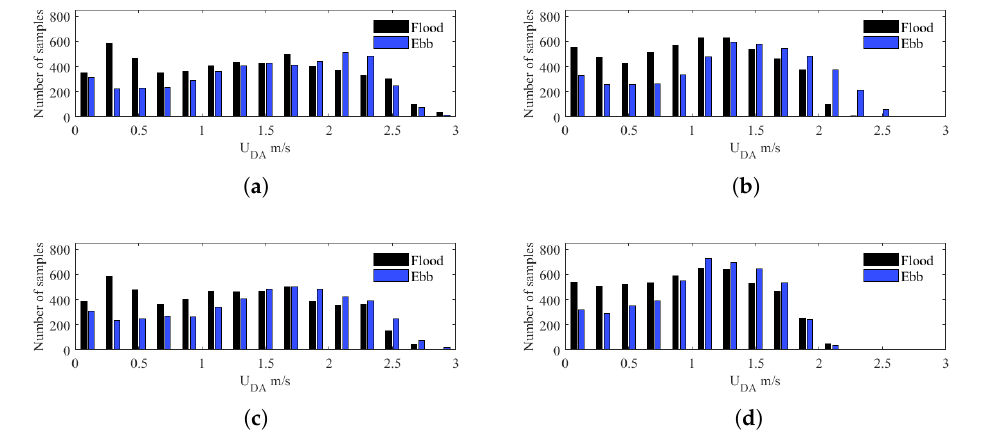
Figure 3. Number of samples for each vertical turbine position at each turbine location in the site, for a range of U DA , between September and November 2014. ( a ) Near Surface, Location A. ( b ) Near Surface, Location B. ( c ) Near Bed, Location A. ( d ) Near Bed, Location B.